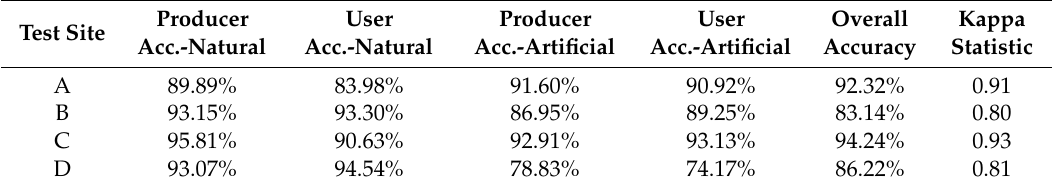
Table 3. Pre-classification accuracies for the test sites (column 1) using the full BSL setting comprise grouped producer and user accuracies within natural (columns 2–3) and within artificial material classes (columns 4–5) demonstrating the general separation of the broad classes natural and artificial. Overall accuracies (column 6) and kappa statistics (column 7) reveal the general pre-classification accuracies of single material classes.